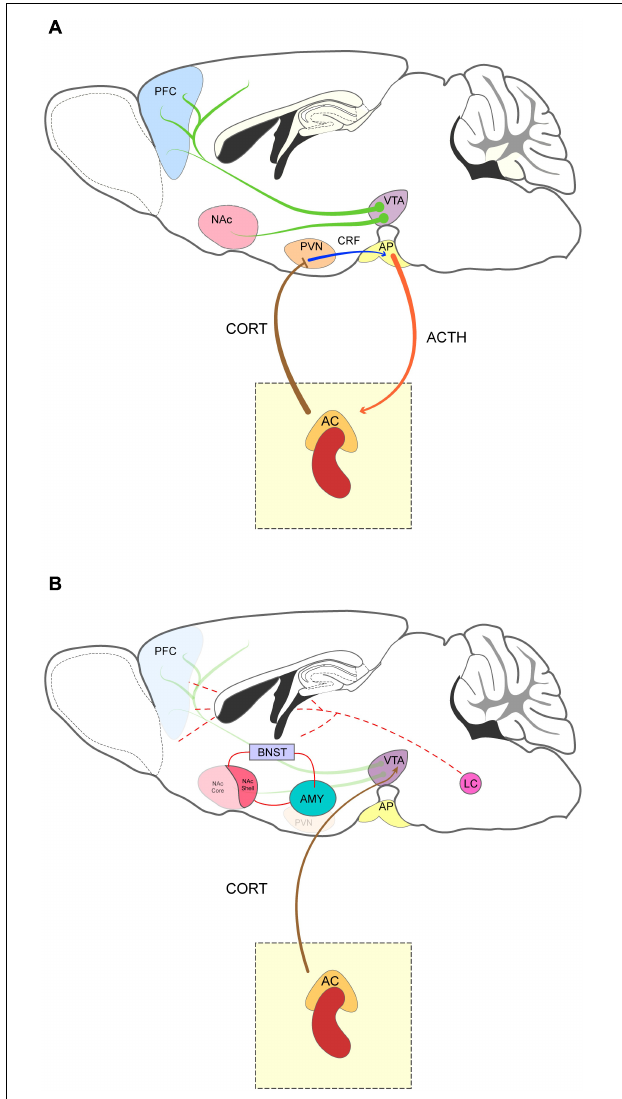
FIGURE 1 | Sagittal representation of the mesocorticolimbic system and the brain stress-related areas. (A) The mesocorticolimbic system is composed of dopamine projection neurons (green arrow) that innervate the nucleus accumbens (NAc) and prefrontal cortex (PFC). Drugs of abuse such as cocaine or amphetamine increase the activity of VTA neurons and lead to dopamine release in the NAc and PFC. The HPA axis comprises the paraventricular nucleus of the hypothalamus (PVN), the anterior pituitary gland (AP) and the adrenal cortex (AC). Stressful stimuli activate the PVN, which releases CRF (blue arrow) in the AP and stimulates adrenocorticotropic hormone (ACTH) (orange arrow) secretion into the bloodstream. In turn, ACTH reaches the AC to induce release of corticoids (CORT, brown arrow). Activation of the HPA is terminated by a negative feedback mechanism induced by corticoids in the PVN and AC. Acute and chronic exposure to stress lead to vulnerability to drug addiction by strengthening plasticity across the mesocorticolimbic pathway. Indeed, stress induces DA release in the PFC and NAc and “ sensitizing ” VTA neurons (Saal et al., 2003). (B) Relevant stress-related areas and their interaction with the brain’s reward system. Corticosteroids from the adrenal gland stimulate the VTA and the extended amygdala [bed nucleus of the stria terminalis (BNST), amygdala (AMY), and the shell of the NAc]. The arousal system and the noradrenergic projections from the locus coeruleus (LC) is also represented (dashed